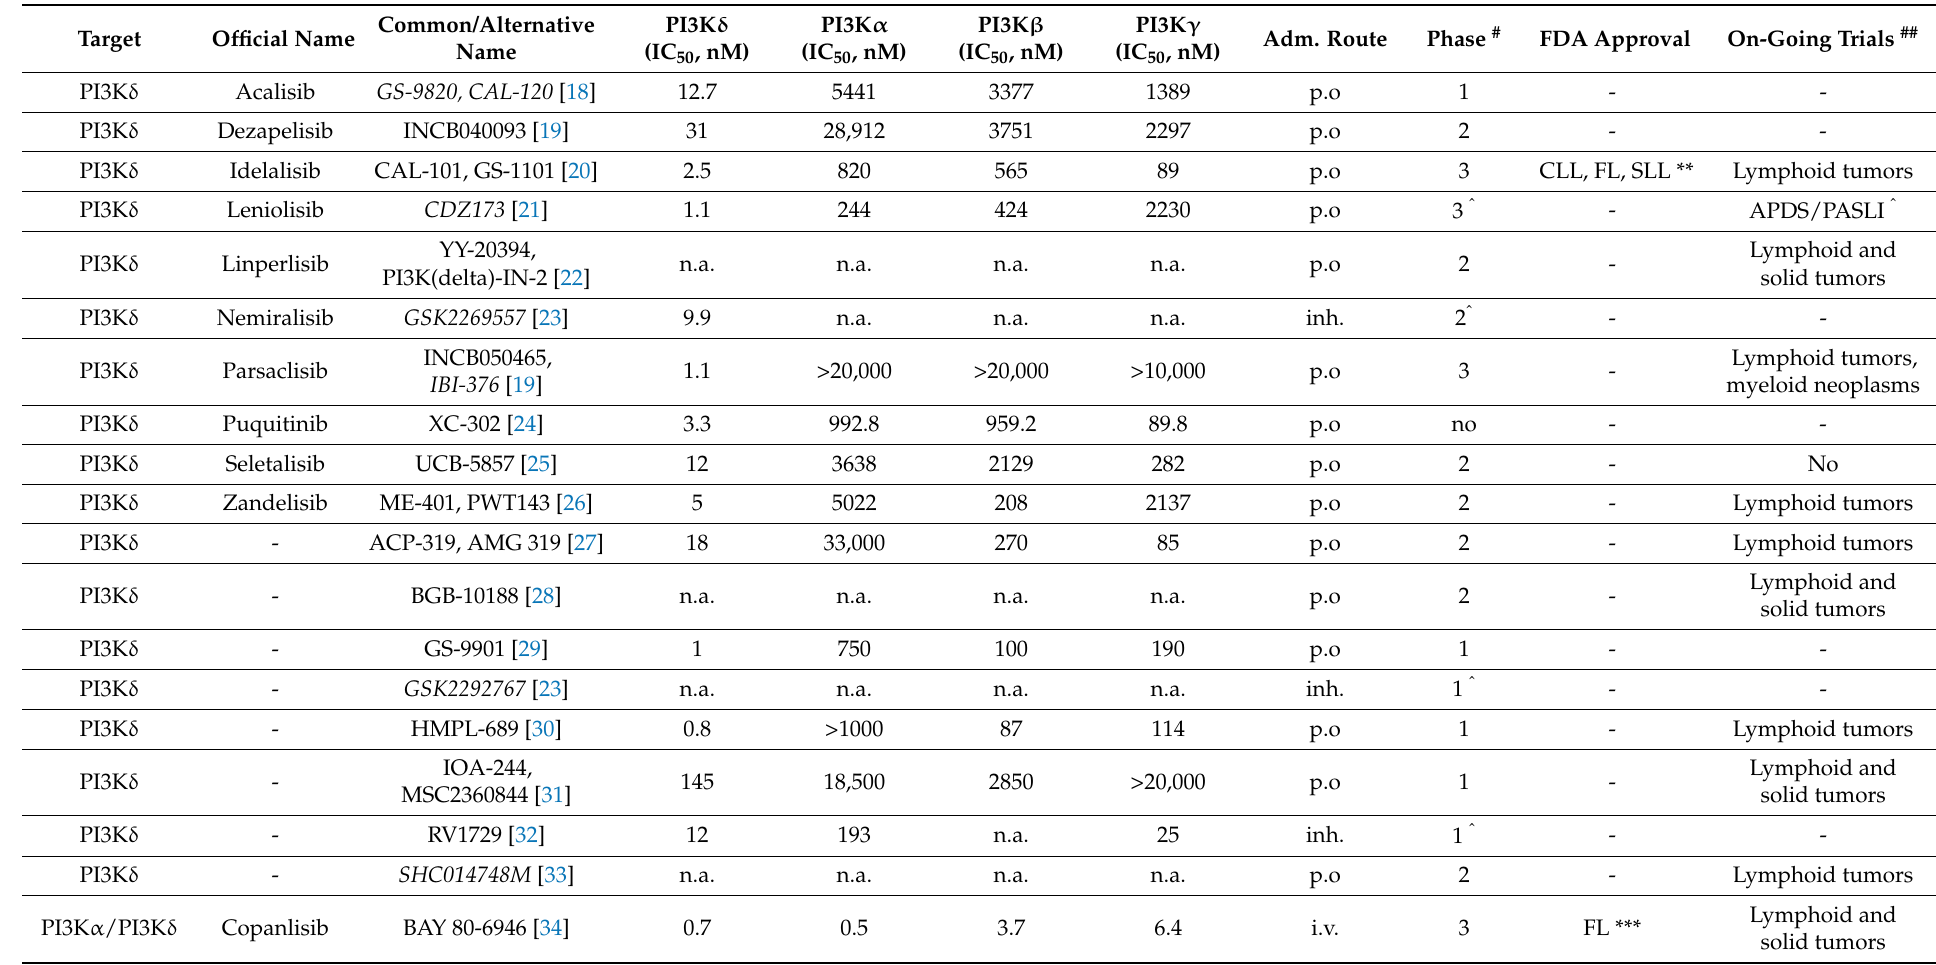
Table 1. List of P3Kdelta inhibitors sorted by their target, their official name, if assigned, or by their common/alternative name.